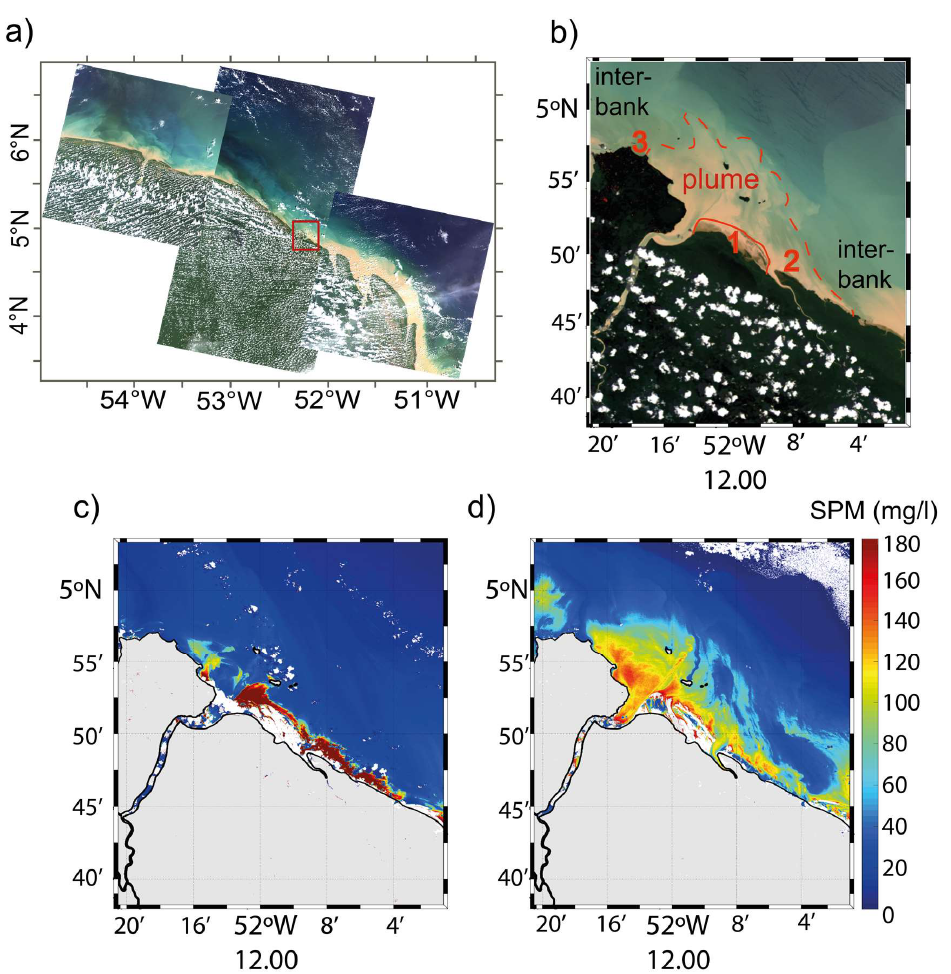
Figure 1. ( a ) Landsat 8 scenes covering French Guiana’s coast. ( b ) Mud bank located in front of the Cayenne Island, where (1) corresponds to the intertidal part, (2) to the back of the bank, and (3) to the front of the bank and the plume is delimited by the red line (approximate definition). ( c ) SPM values for the Landsat 8-OLI image for 29 July 2015. ( d ) SPM values for the Landsat 8-OLI image for 30 August 2015.